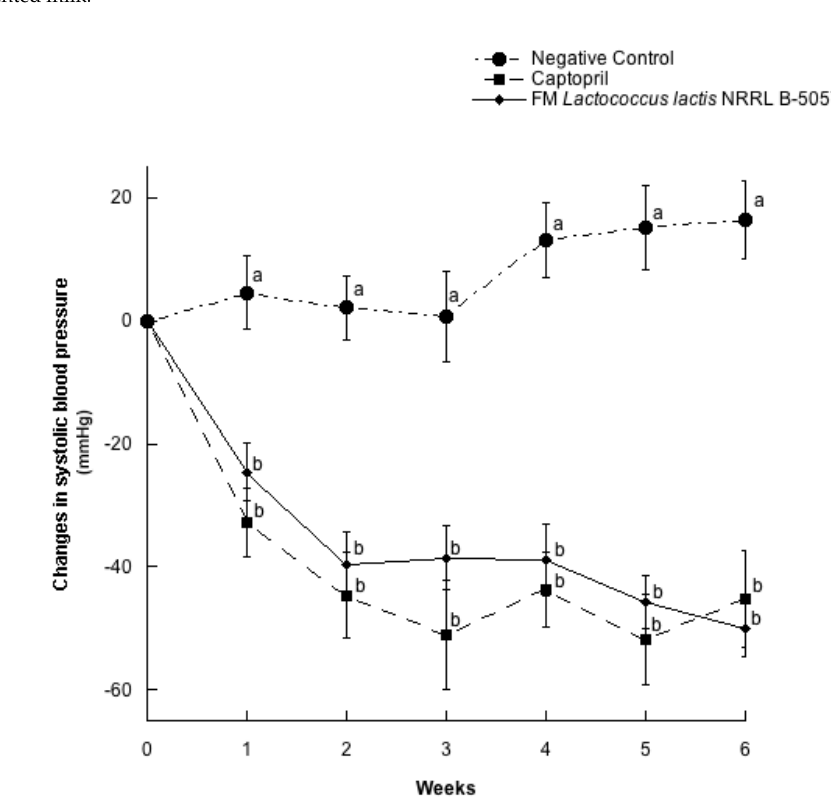
Figure 3. Change in systolic blood pressure in spontaneously hypertensive rats with different treatments. Negative control: purified water; Captopril: 40 mg/kg body weight; FM L. lactis NRRL B-50571 (ad libitum): fermented milk with L. lactis NRRL B-50571. Data are presented as means ± SEM. Data points sharing the same letter within a week was not significantly different ( p > 0.05).